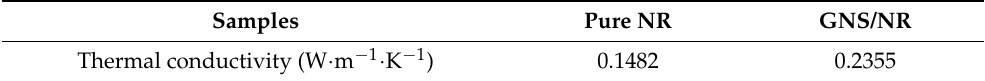
Table 2. Thermal conductivity of the pure natural rubber and the graphene/natural rubber composites.